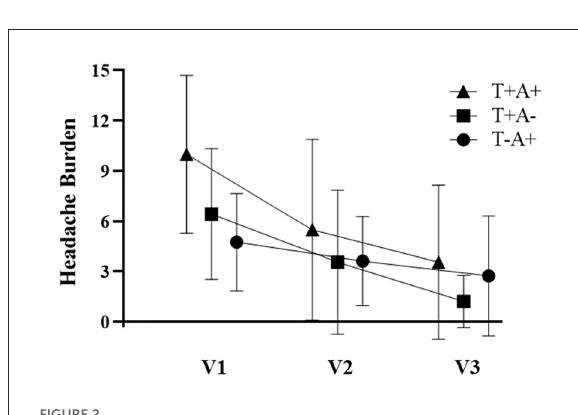
FIGURE2 Headache Burden for RAMP1 + CALCA genotype subgroups across the 3 study visits (V1, V2, and V3, respectively). Data are presented as group mean ± SD. Repeated-measures ANOVA revealed the presence of significant group ( p < 0.001, partial η 2 = 0.633) and visit main effects ( p < 0.001, η 2 = 0.404), but the interaction effect did not achieve statistical significance ( p =